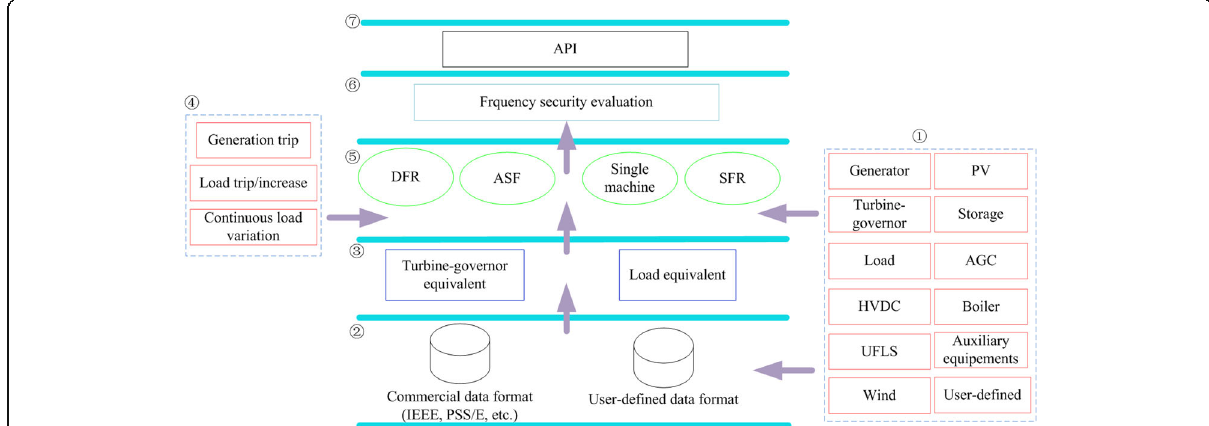
Fig. 4 Framework of the proposed package for frequency response